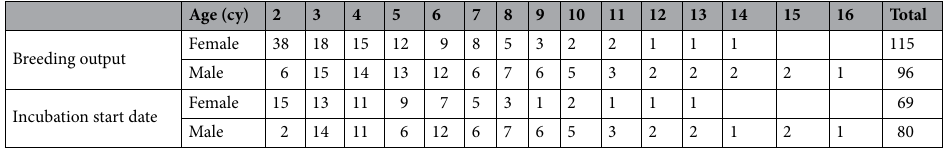
Table 3. data size used in age-specific reproductive performance analyses for each age group. Age is in calendar years. Females indicate the number of females in each age group included in analyses and males the same for males. In the “Breeding output” row we show the number or records of each age and sex included in Averaged Breeding Residual (ABR) analyses while in the “Incubation start date” we indicate the number of records used relative incubation start date